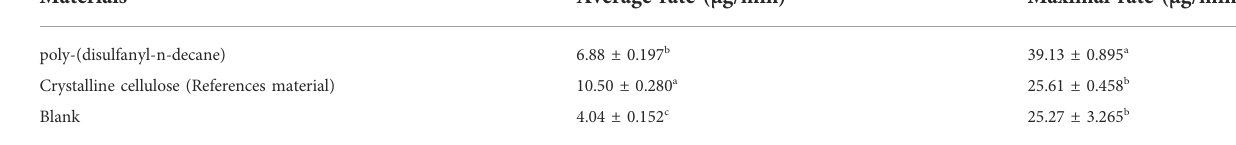
TABLE 1 CO 2 evolution rate of